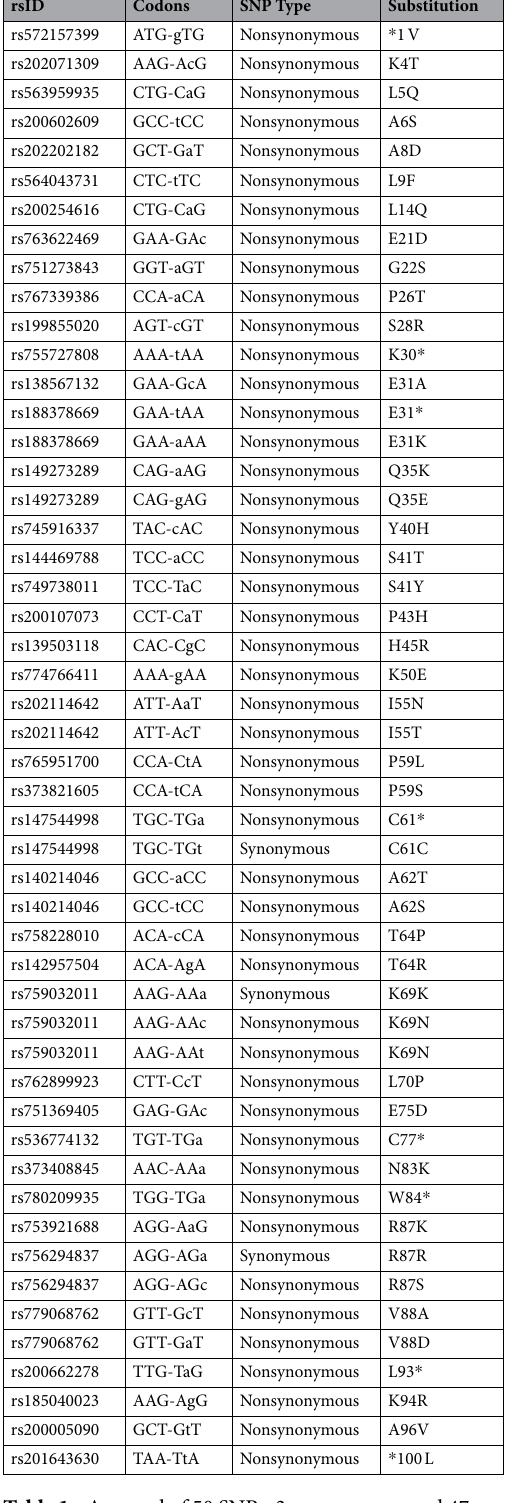
Table 1. A record of 50 SNPs, 3 synonymous and 47 non-synonymous, associated with 41 rsIDs in the IL8 coding